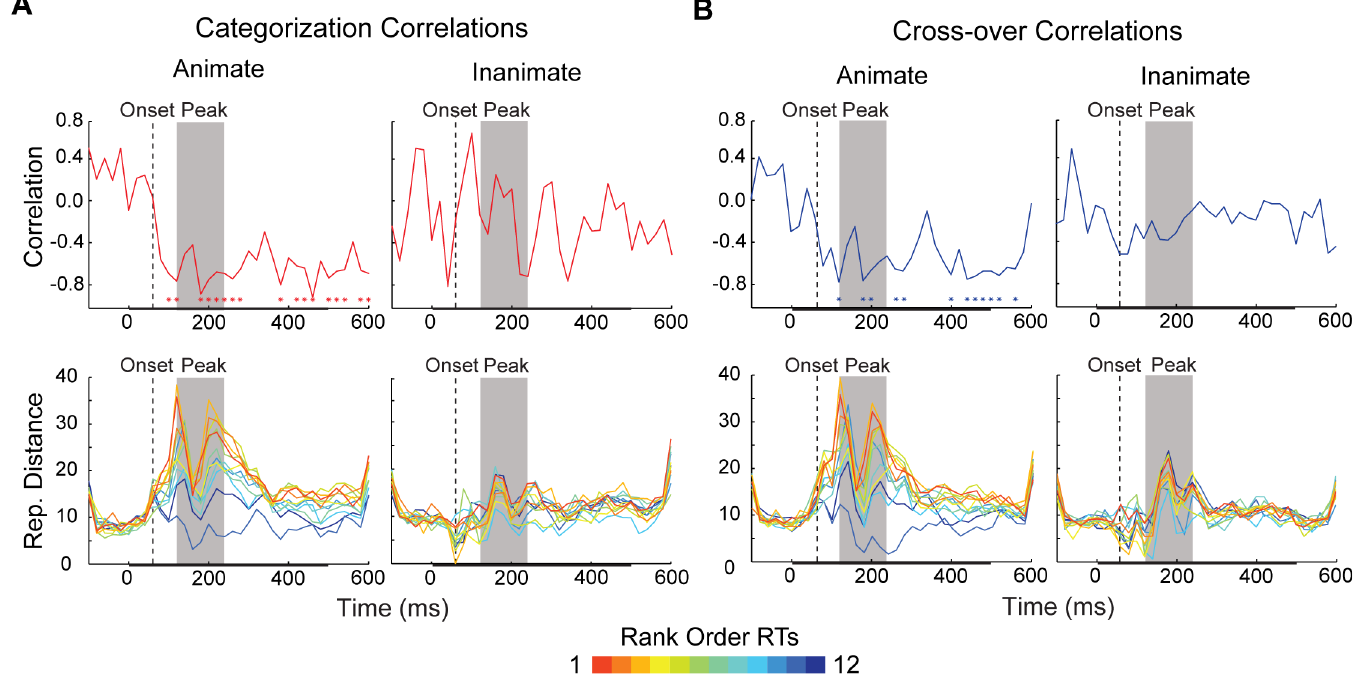
Fig 6. Time varying representational distance for individual exemplars separated by object category. Time varying (A) categorization task (red) and (B) cross-over (blue) rank-order correlations (Spearman ’ s ρ ) for animate and inanimate exemplar stimuli. The color-coded asterisks in the top row of plots indicate time points at which there is a significant correlation between distances and RTs ( * = FDR adjusted p < 0.05). The bottom row of plots displays the distances from animacy decision boundaries at each time point, computed for both the categorization task and distractor task data sets. Each time-varying line depicts the representational distance for an individual exemplar stimulus, at each 20 ms time point (either animate or inanimate). The color of each line is based on the rank-order of the median RT for each exemplar (rank is always within category). In all plots, decoding onset is indicated by dashed vertical line (60 ms). The period of peak decoding is indicated by a gray box extending 120 – 240 ms post-stimulus onset. The bar along the x-axis indicates the stimulus